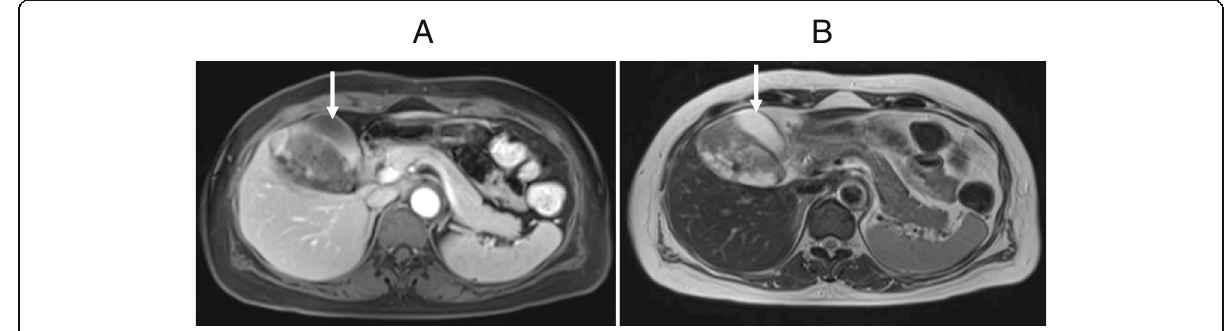
Fig. 3 Abdominal magnetic resonance imaging found a tumor between the gallbladder (white arrow) and the liver. a T1 W1. b T2 W1